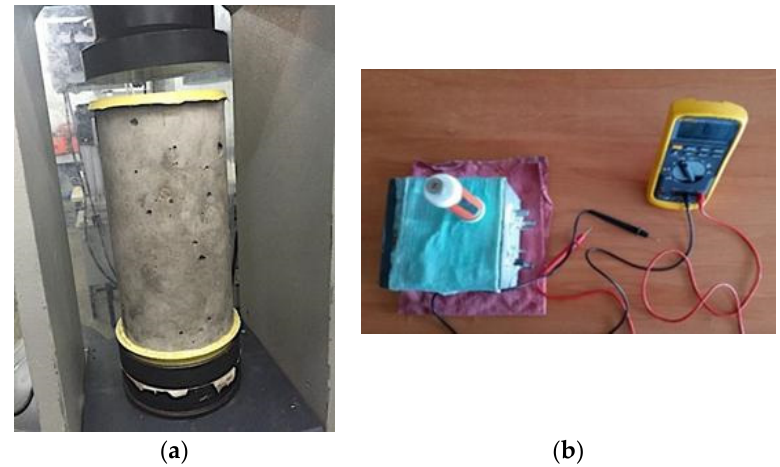
Figure 2. Experimental test conducted on green concrete: ( a ) compressive strength and ( b ) electrochemical corrosion monitoring.